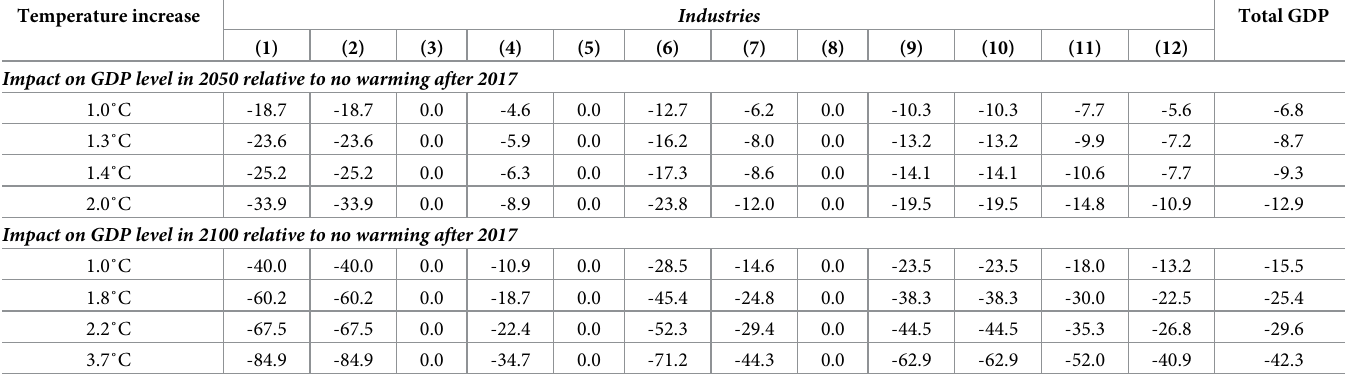
Table 11. Simulated impact (in %) of the climate change on the industry and overall GDP level and growth rates in Chile for the future � . Temperature increase Industries